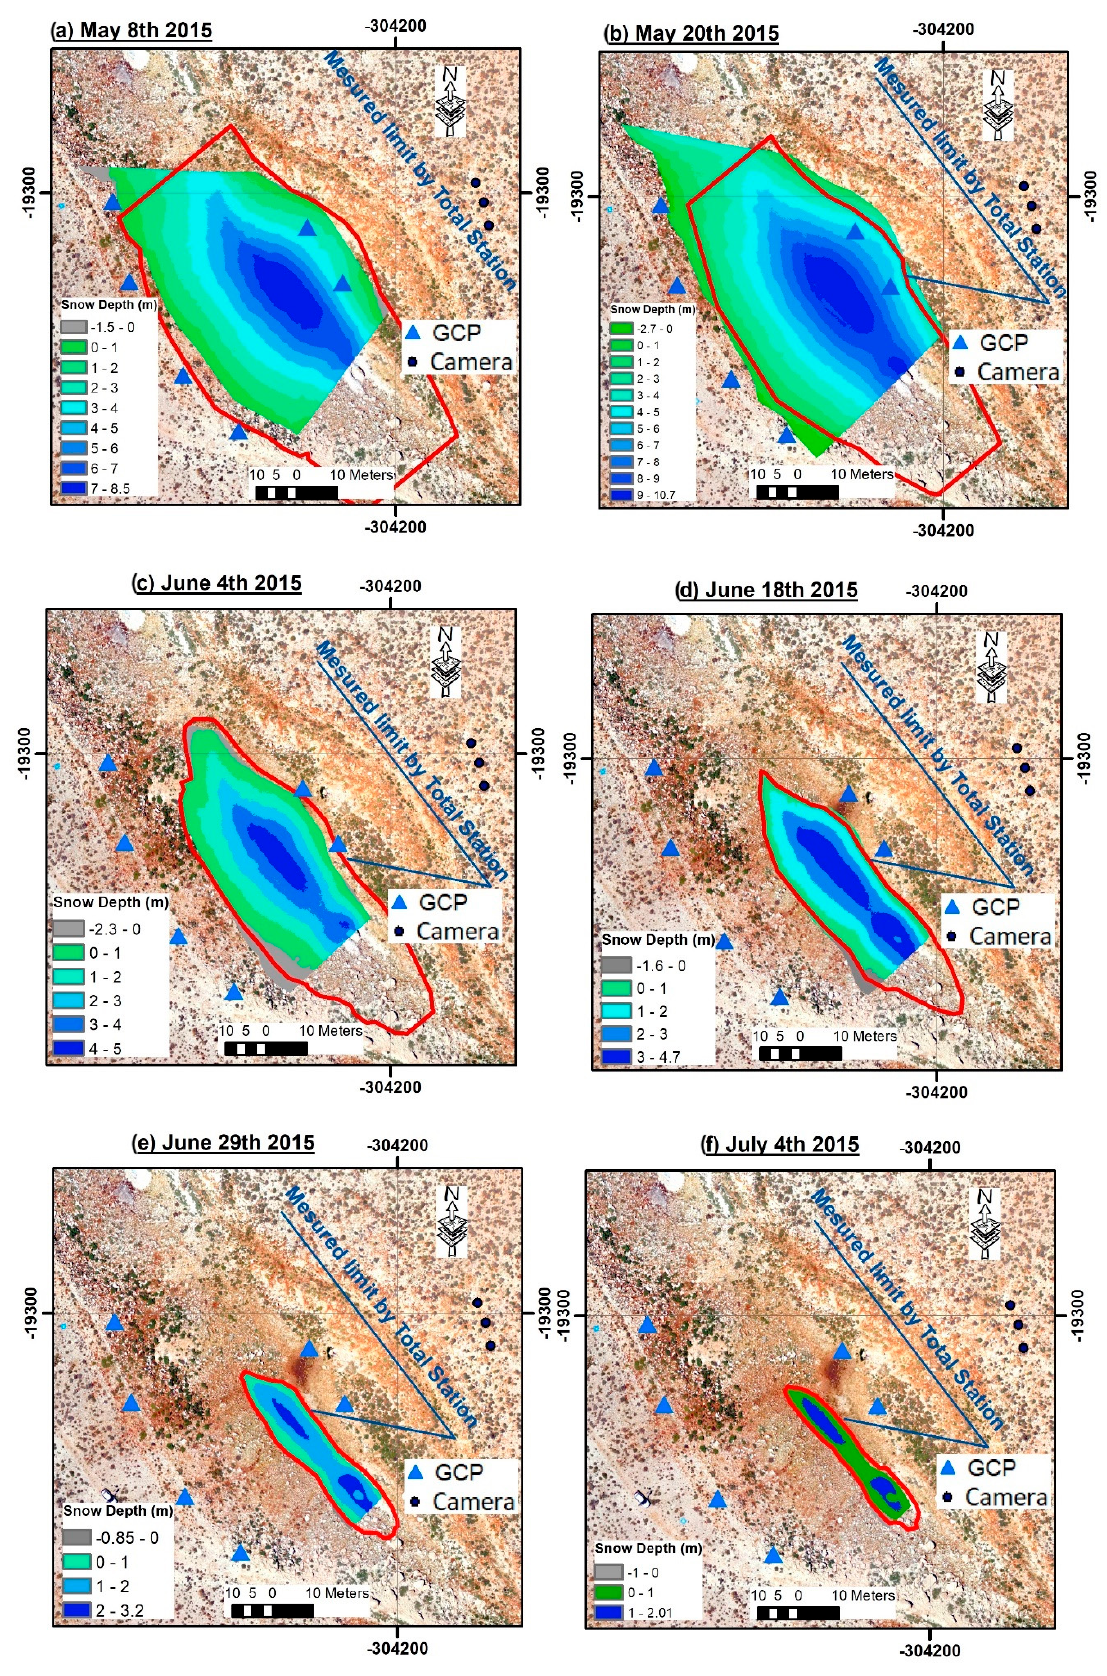
Figure A3. Snow depth maps of Exp.3.